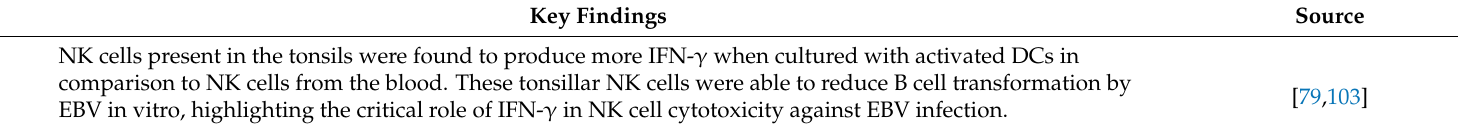
Table 2. Summary of soluble mediators affecting NK-mediated restriction of EBV infection. Key